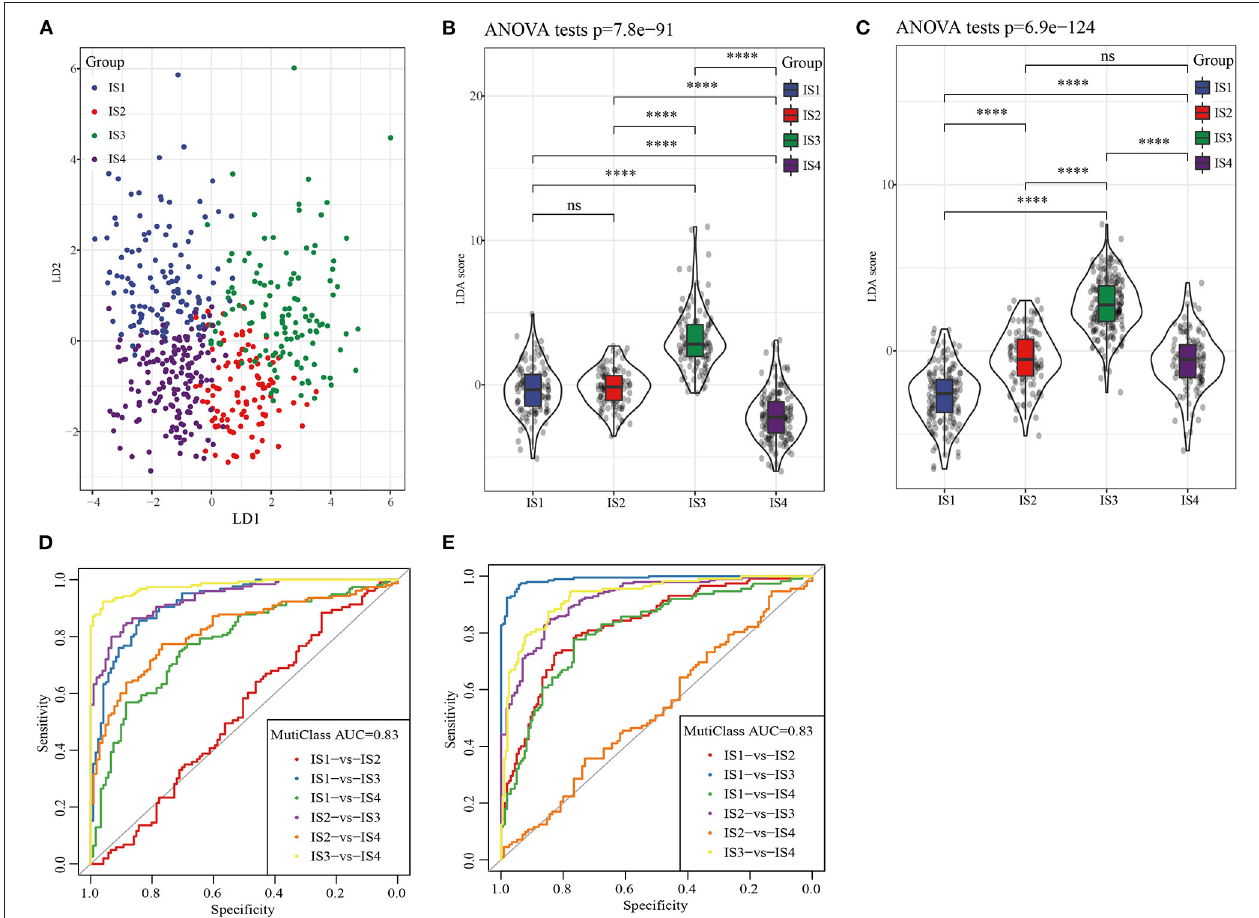
FIGURE 6 | LDA was used to construct a scoring system based on immune cell signatures. (A) LDA diagram of four ISs patients in TCGA cohort. (B) The violin diagram showed the different LDA score between IS1, IS2, IS3, and IS4 in TCGA. (C) Difference analysis of LDA score of four ISs patients in GEO database. (D) Receiver operating characteristic (ROC) curves of LDA score in the TCGA. (E) Receiver operating characteristic (ROC) curves of LDA score in the